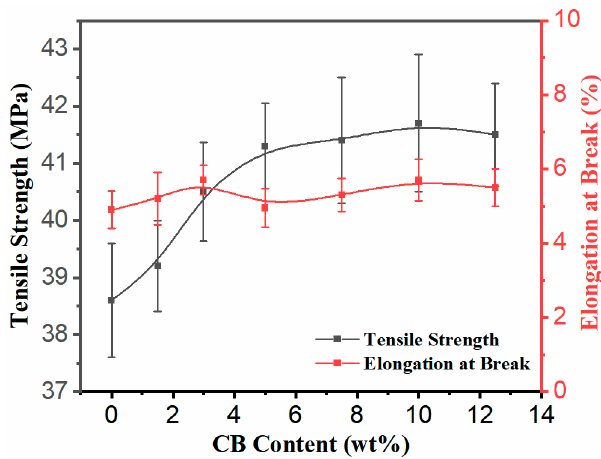
Figure 7. Tensile properties of PLA70/30HDPE/CB blends with different CB loadings.